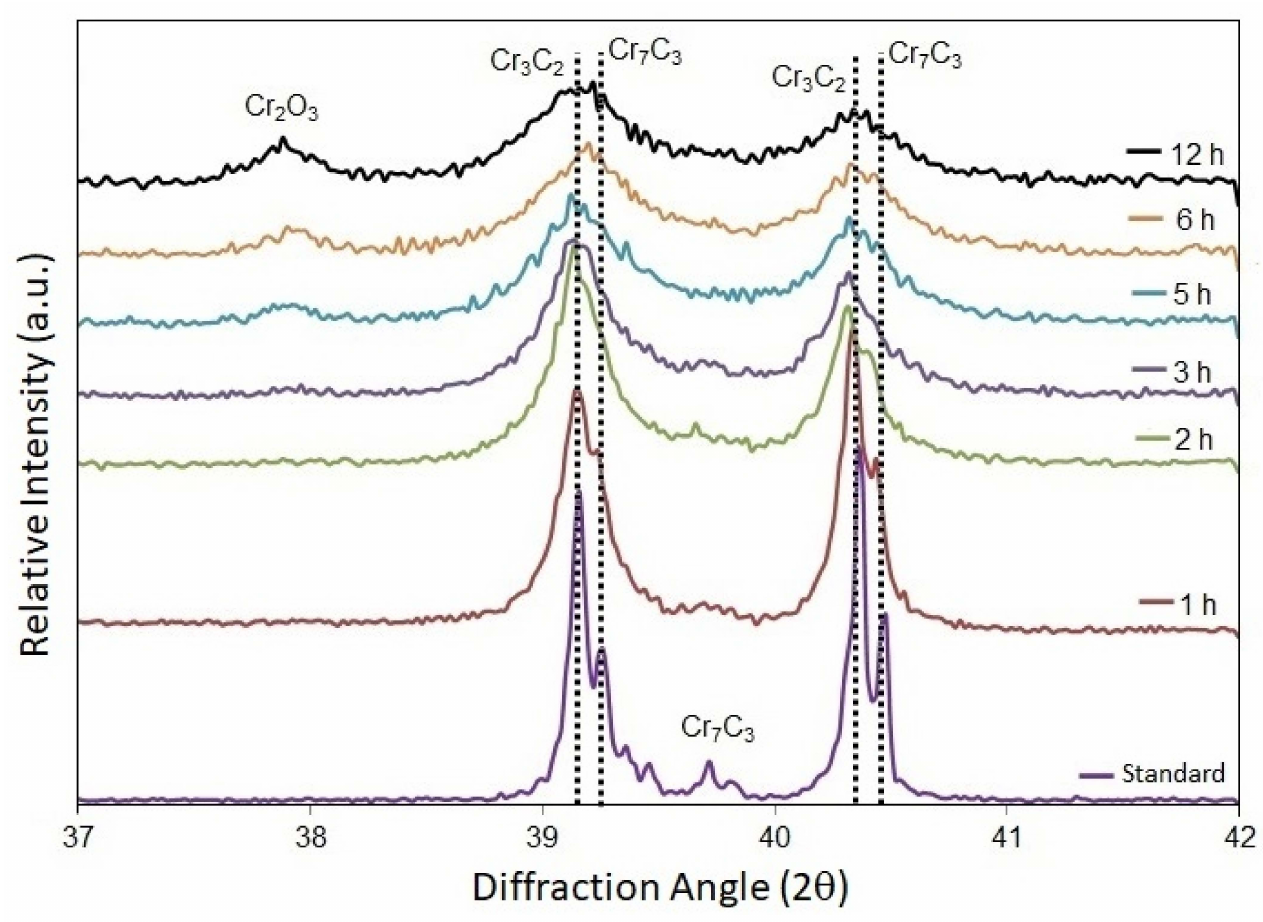
Figure 2. XRD analysis of the Cr 3 C 2 and Cr 7 C 3 as a function of high-energy milling